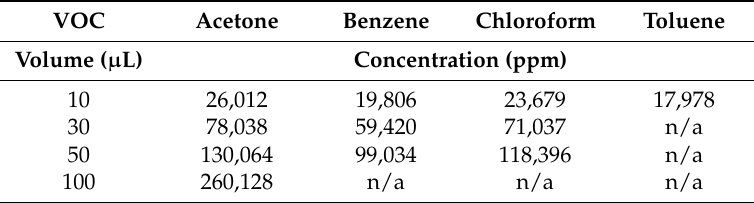
Table 1. Relation between the injected volume and the concentration of the volatile organic compound (VOC). (VOC).